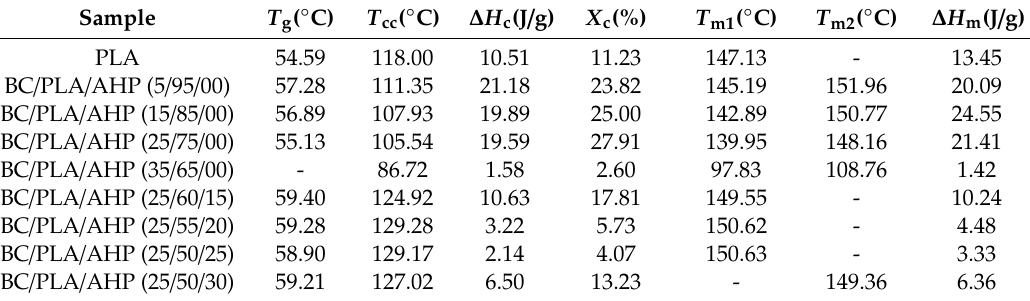
Figure 1. Heat flow curves of ( a ) PLA and BC / PLA, ( b ) BC / PLA / AHP with di ff erent amount of AHP added. Table 1. DSC testing data of PLA, BC / PLA, and BC / PLA /